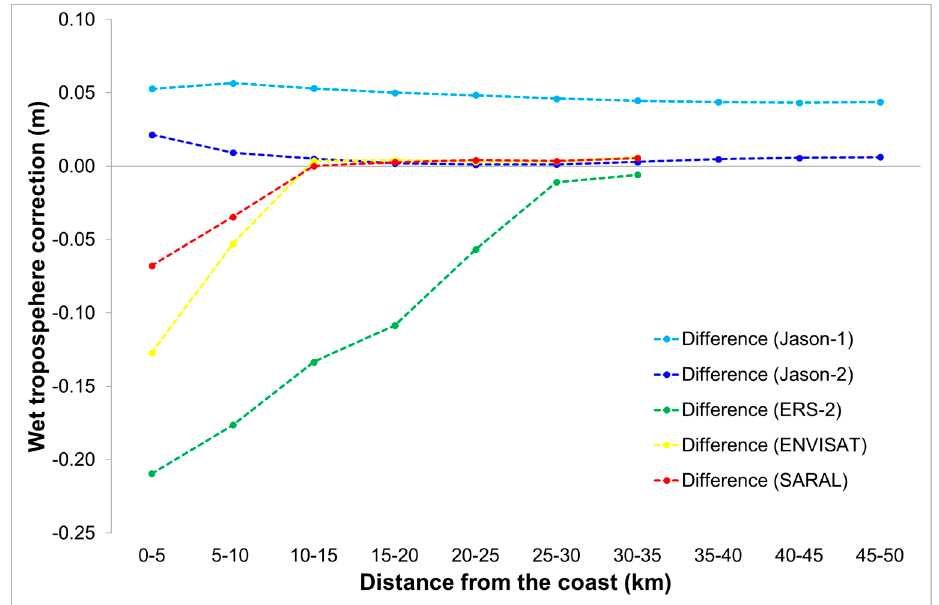
Figure 10. Difference between wet troposphere corrections from ECMWF and radiometer measurements for Jason-1 (light blue), Jason-2 (blue), ERS-2 (green), Envisat (yellow), and SARAL (red).